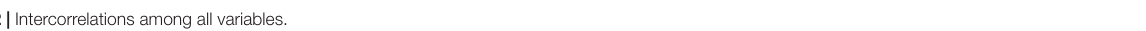
TABLE 2 | Intercorrelations among all